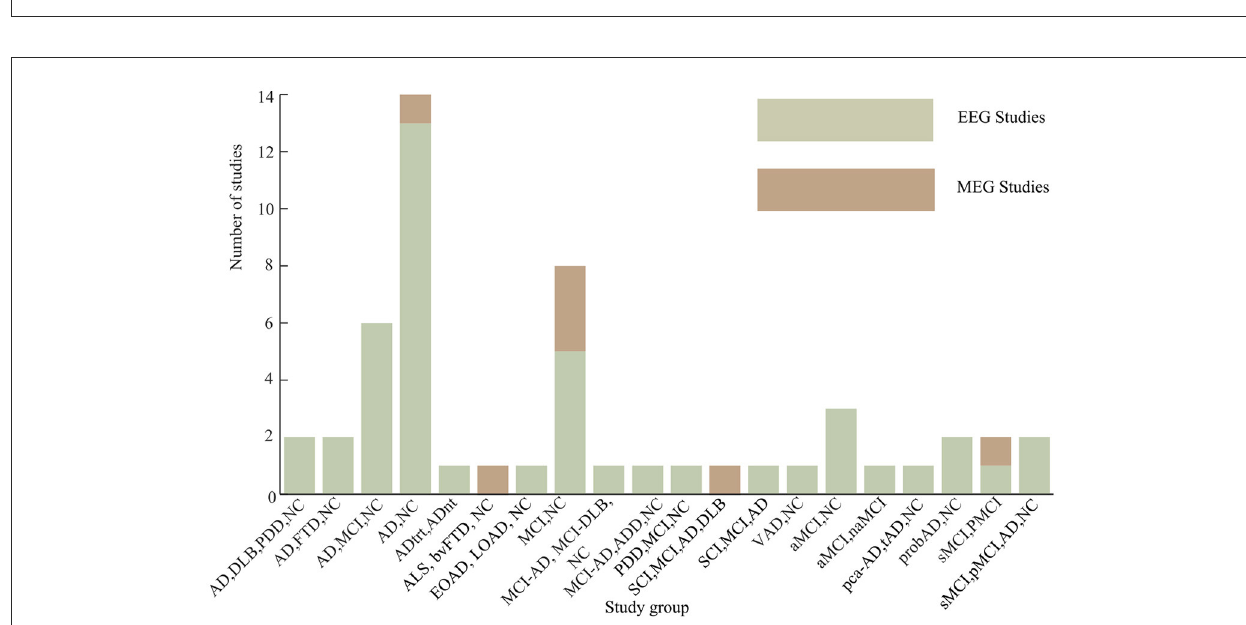
FIGURE6 Groups of dementia-related disorders